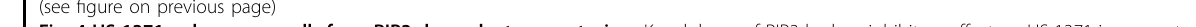
Fig. 4 HS-1371 only rescues cells from RIP3-dependent necroptosis. a Knockdown of RIP3 had no inhibitory effect on HS-1371 in necroptosis. HT-29 cells expressing RIP3 shRNA, MLKL shRNA, or non-silencing control were analyzed by western blotting (upper panel), and these cells were treated with TSZ (6 h for immunoblotting, 24 h for cell death assay). Cell lysates were analyzed by immunoblotting (middle panel), and cell viability was analyzed by MTT assay (bottom panel). The results are presented as means ± SEM. * P < 0.05, ** P < 0.01, *** P < 0.001. b HS-1371 protected cells not only from TNF-induced necroptosis but also from TRAIL-induced necroptosis. HT-29 cells were pretreated with indicated concentrations of HS-1371 and then treated with TRAIL + Smac + zVAD (6 h for immunoblotting, 24 h for cell death assay). Cell lysates were analyzed by immunoblotting, and cell viability was analyzed by MTT assay or phase-contrast microscopy. The results are presented as means ± SEM. * P < 0.05, ** P < 0.01, *** P < 0.001. c , d HS-1371 had no effect on TNF-induced apoptosis. HT-29 cells were pretreated with HS-1371 (5 μ M) for 2 h and then treated with TC or TS (TNF + either cycloheximide or SMAC mimetic, hereafter referred to as TC or TS, 6 h for immunoblotting, 24 h (TC) or 36 h (TS) for cell death assay). Cell lysates were analyzed by immunoblotting, and cell viability was analyzed by MTT assay (TC) or CellTiter-Glo Luminescent Cell Viability Assay Kit (TS). The results are presented as means ± SEM. * P < 0.05, ** P < 0.01, *** P <